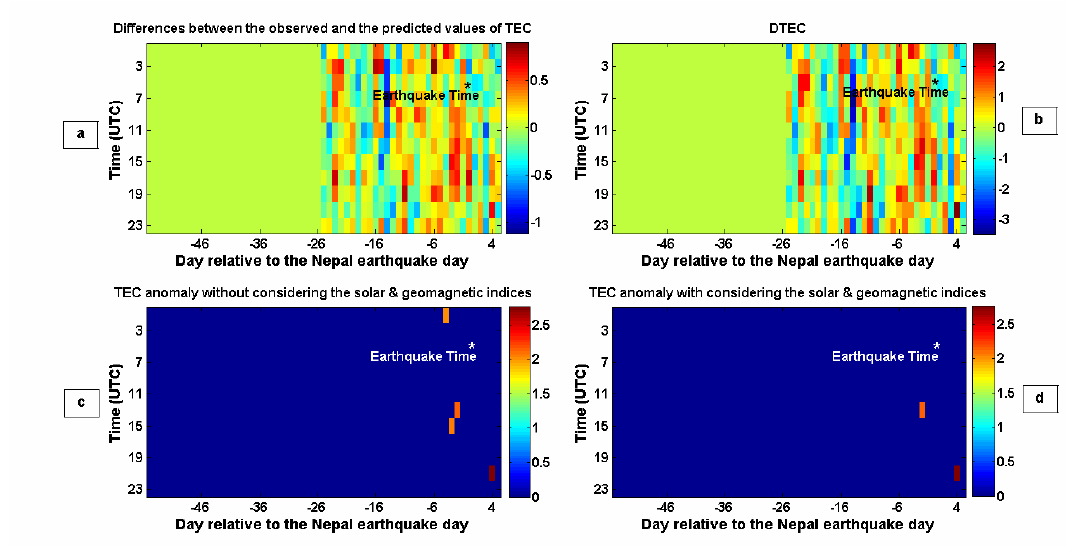
Fig. 5. a) Differences between the observed and the predicted values of TEC obtained from ANN method. b) DTEC variations. c) Detected anomalies using ANN method without considering the geomagnetic indices. d) Detected anomalies using ANN method with considering the geomagnetic indices. The X-axis represents the days relative to the Nepal earthquake day. The Y-axis represents the universal time